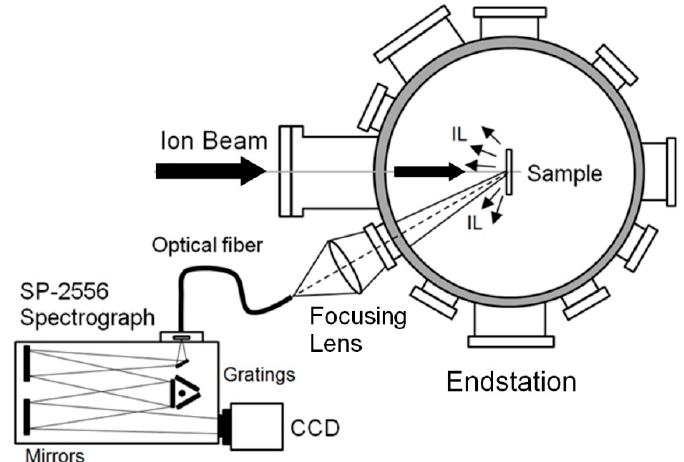
Figure 2. Schematic of the experimental setup for in-situ ionoluminescence (IL) measurements reprinted from Crespillo et al. [50], Copyright (2016), with permission from Elsevier.